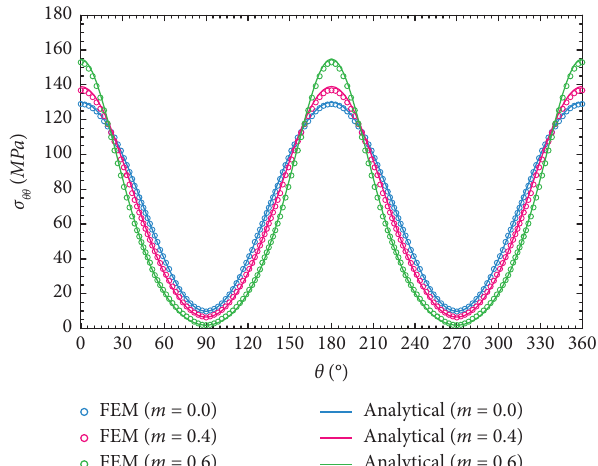
Figure 5: Tangential stress in the borehole wall for diferent values of m .